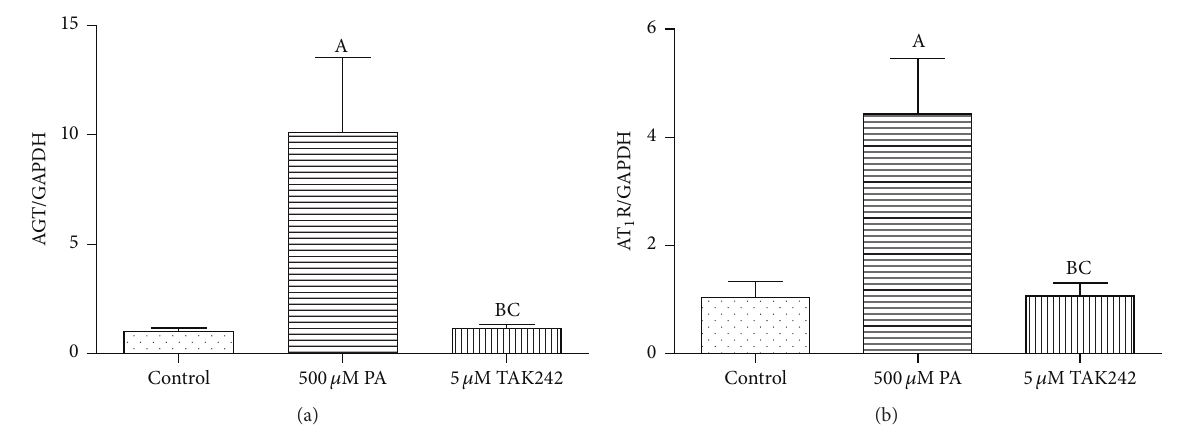
Figure4:TAK242pretreatmentpreventedupregulationofAGTandAT 1 RmRNAexpressions.Dataarepresentedasmean ± SD.(A) 𝑃 < 0.05 versus control, (B) 𝑃 < 0.05 versus PA group, and (C) 𝑃 > 0.05 versus control ( 𝑥 ± 𝑠 , 𝑛 = 9 ).